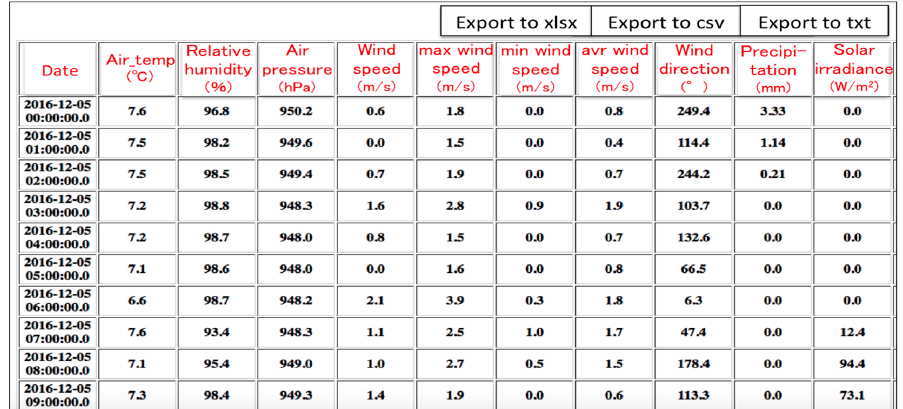
Figure 12. Primary index as a list displayed in web service.